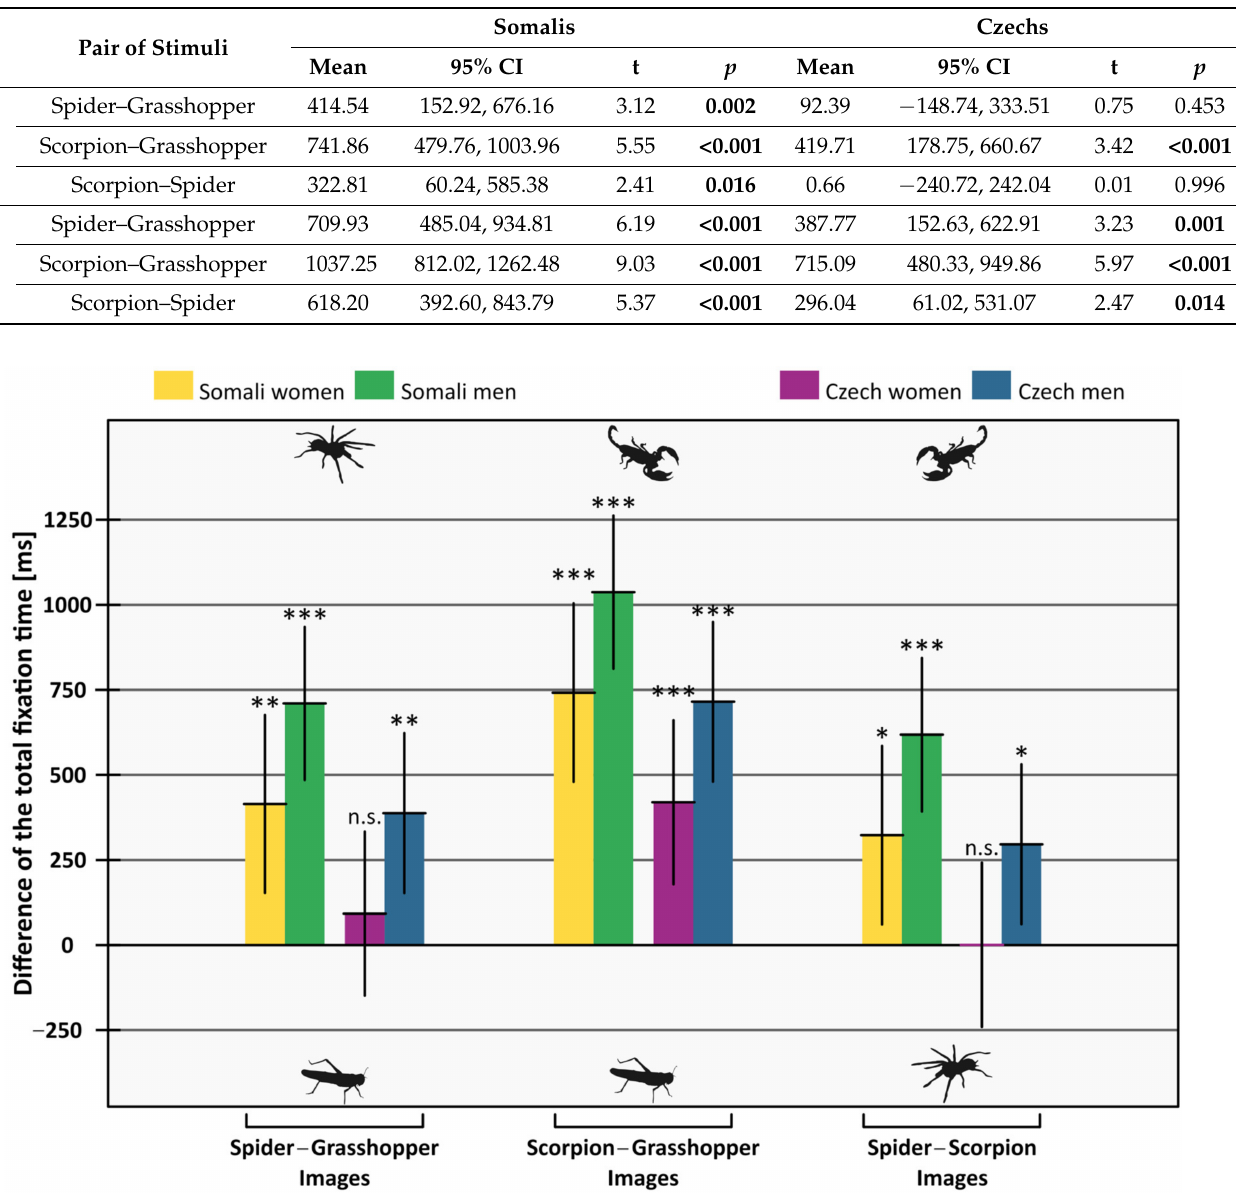
Figure 3. Mean difference of the total fixation time on the two stimuli. When the difference is positive, participants looked more on the first stimuli of the pair (e.g., in Spider − Grasshopper Images, participants looked more on the spiders). Error bars are 95% confidence intervals. Means are tested against zero, significances are indicated by asterisks (n.s. p ≥ 0.05; * p < 0.05; ** p < 0.01; *** p <